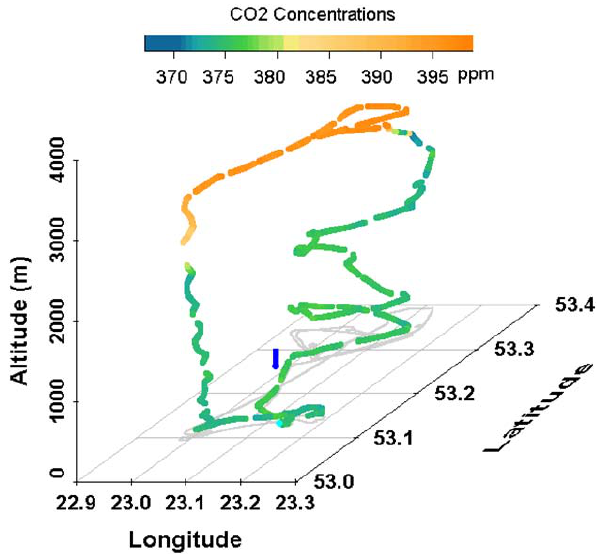
Fig. 13. A flight on 20 August 2008 is shown with the flight track colored by CO 2 mixing ratios: the gray lines show the projected flight tracks on the ground level and the blue bar indicates the loca- tion of the